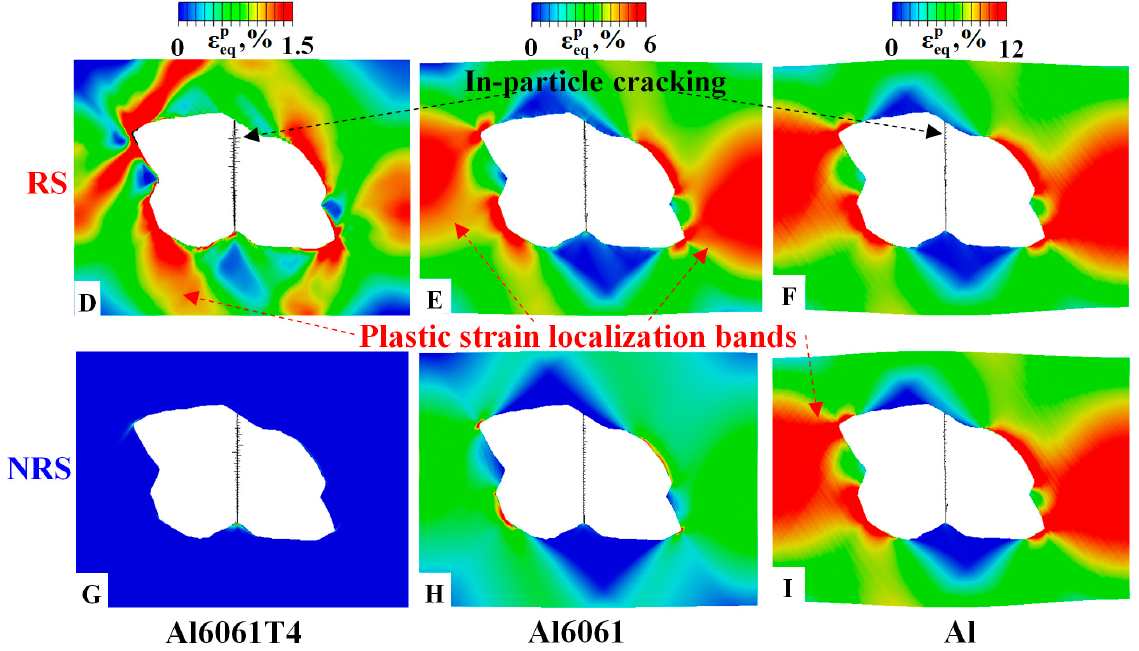
Figure 13. Patterns of fracture and plastic strain localization at composite strains ( D – I ) shown in Figure 7.